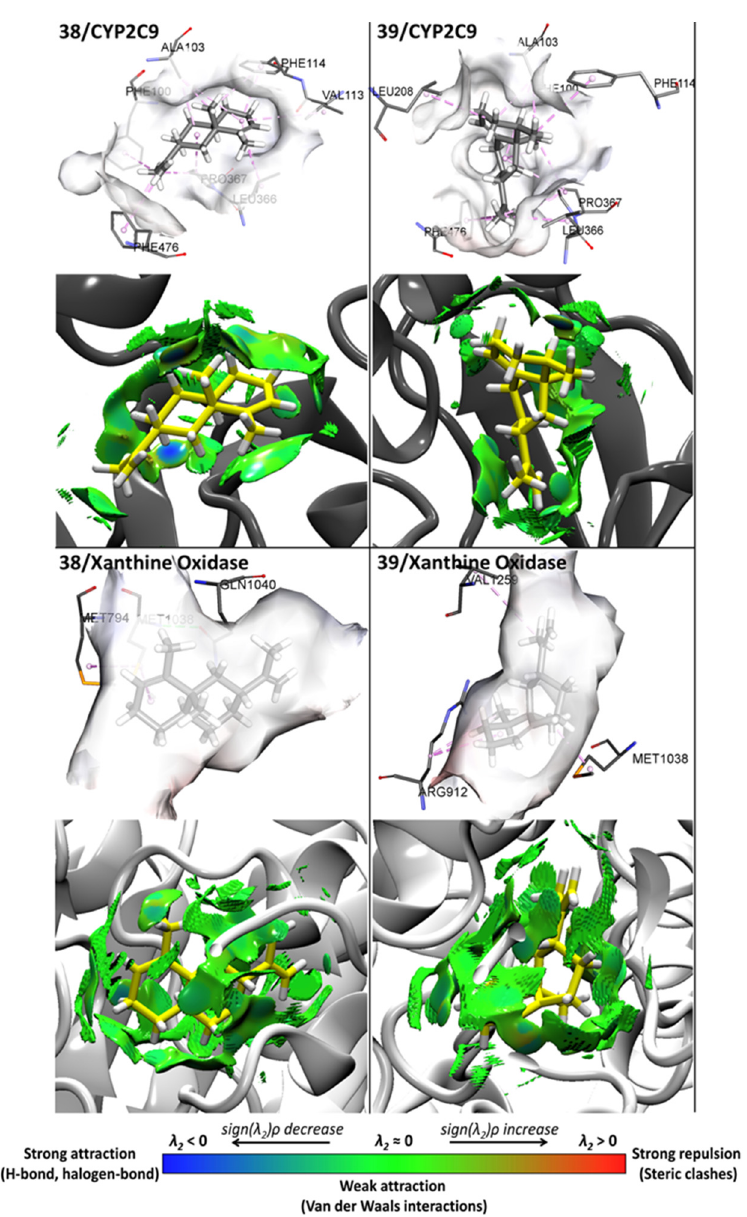
Figure 6. Docking and NCI analysis for the best two compounds, 38 and 39 , of VPEO essential oils bound to CYP2C9 and xanthine oxidase.